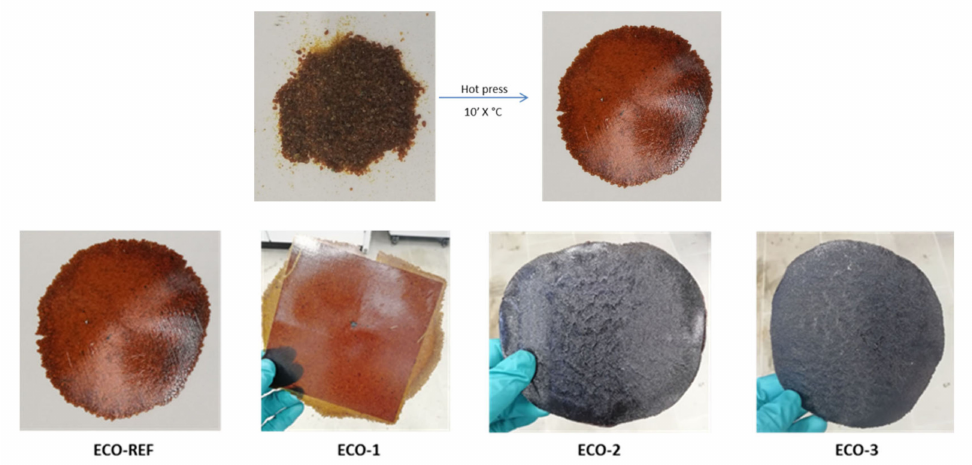
Figure 7. Recycled materials after 10 (cid:48) at: 150 ◦ C (ECO-1); 180 ◦ C (ECO-2), and 200 ◦ C (ECO-3).